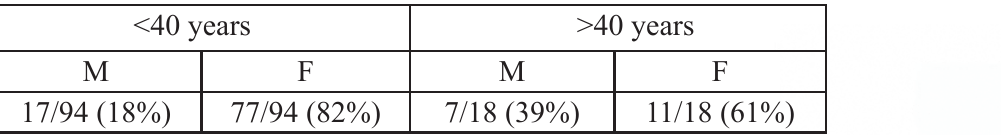
Table 1. Subject numbers (and percentages) for the groups below 40 (<40) and above 40 (>40) years of age are shown. Male and female subjects ( n =112) are indicated (M and F respectively). Percentages have been rounded off and are